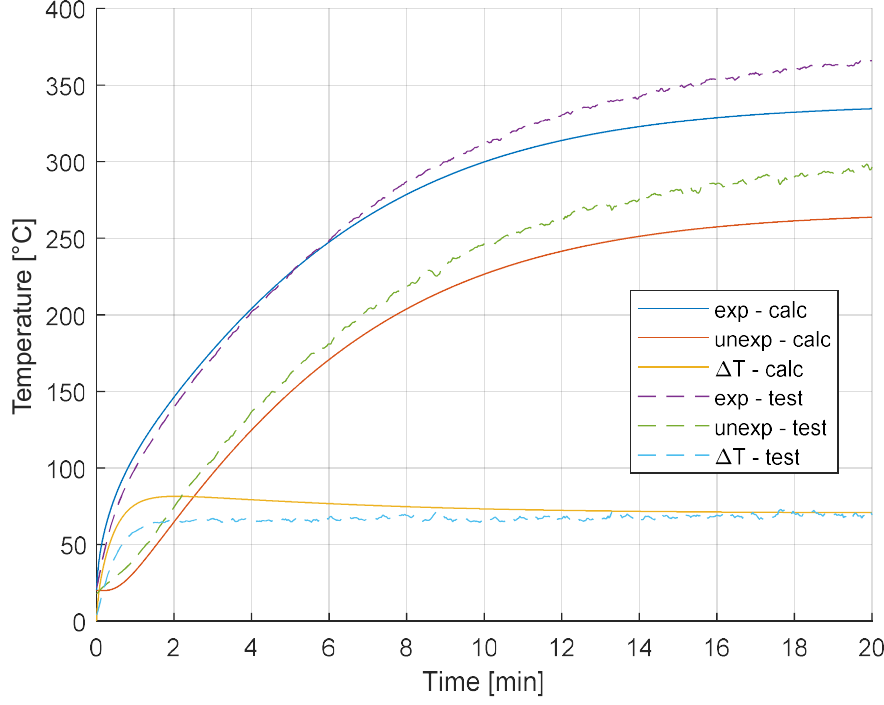
Figure 12. Results of the 1D model compared with the test results at the centre (Test #11).